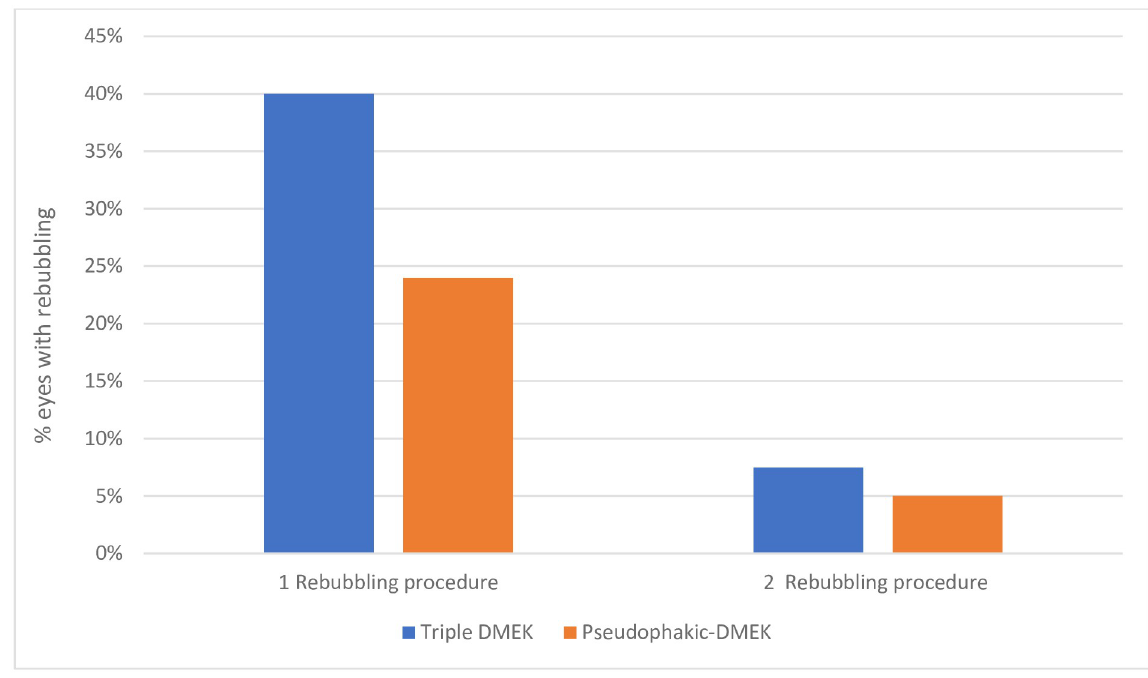
Fig 4. Frequency of one or two rebubbling sessions after surgery. DMEK, Descemet membrane endothelial keratoplasty.